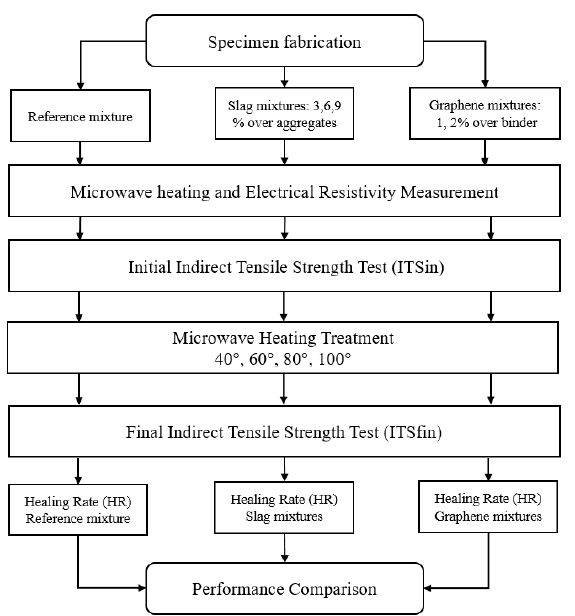
Figure 8. Flow chart of the healing process.